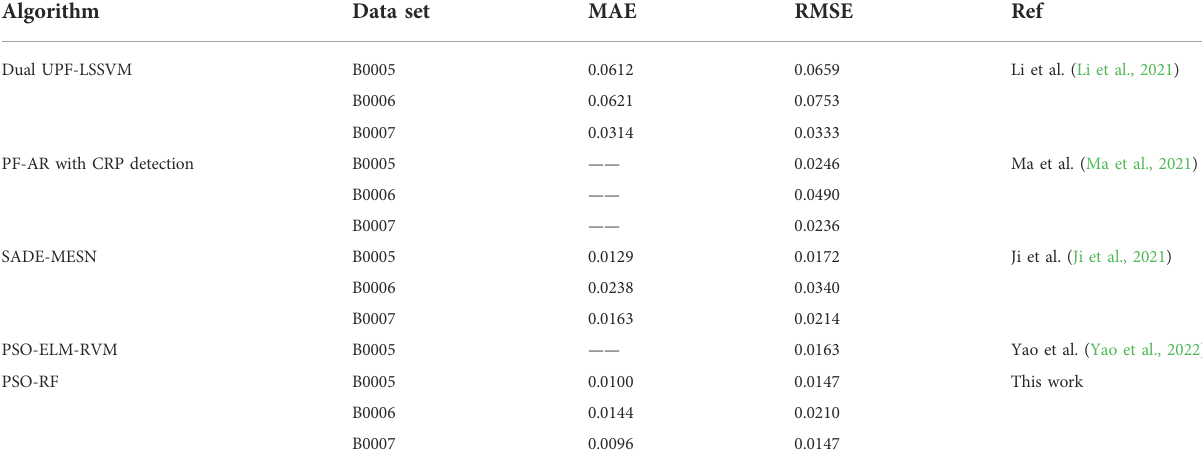
TABLE 5 The prediction results of NASA data